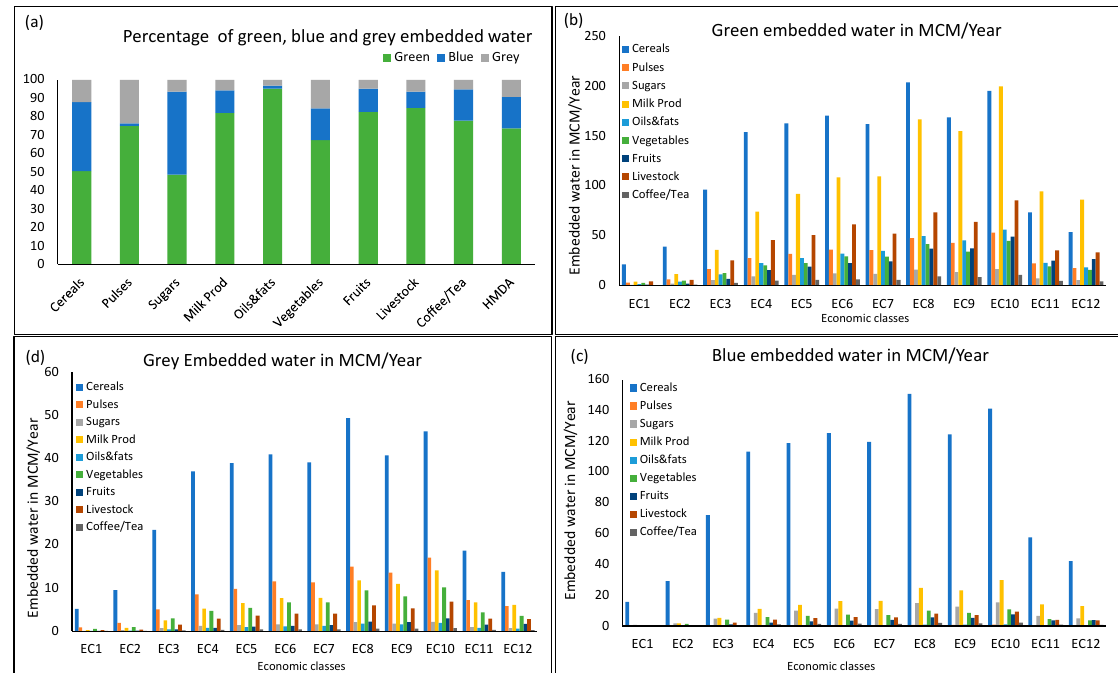
Figure 5. Percentage of green, blue and grey embedded water for each food group and the HMDA region ( a ), as well as the amount of green ( b ), blue ( c ), and grey ( d ) embedded water contents for each food group and each economic class.